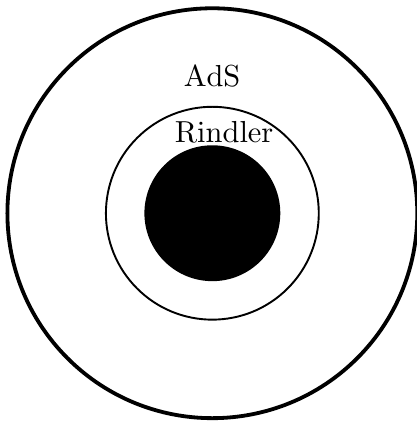
Figure 1 . A black hole in